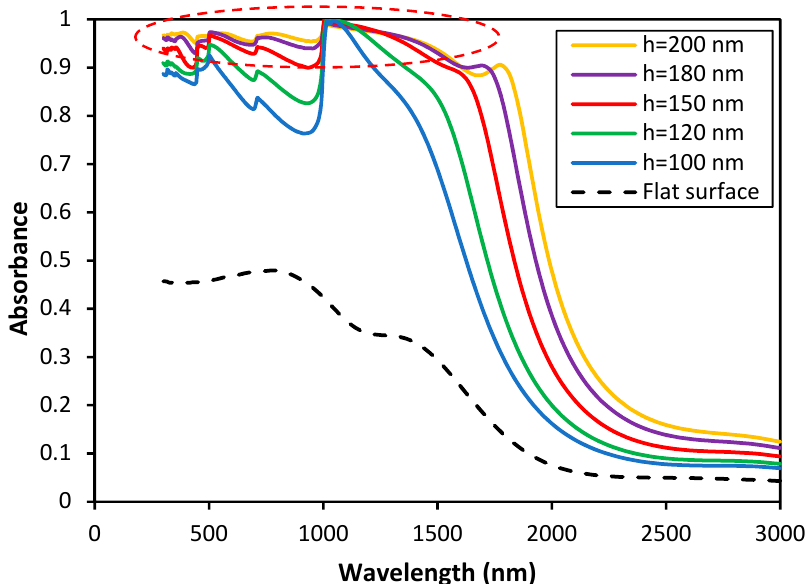
Figure 8. The RMS height effect on the absorbance of the anisotropic rough surface of Tungsten with l x = 100 nm and l y = 400 nm.